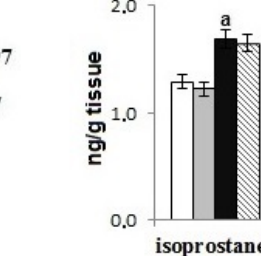
Figure 4. The levels of lipid peroxidation products (MDA and 8-isoPGF 2 ) in the brain of spontaneously hypertensive rats and hypertensive rats after URB597 administration. Data points represent the mean ± SD, n = 6; (a, significantly different from the WKY group, p < 0.05; b, significantly different from the SHR group, p < 0.05.